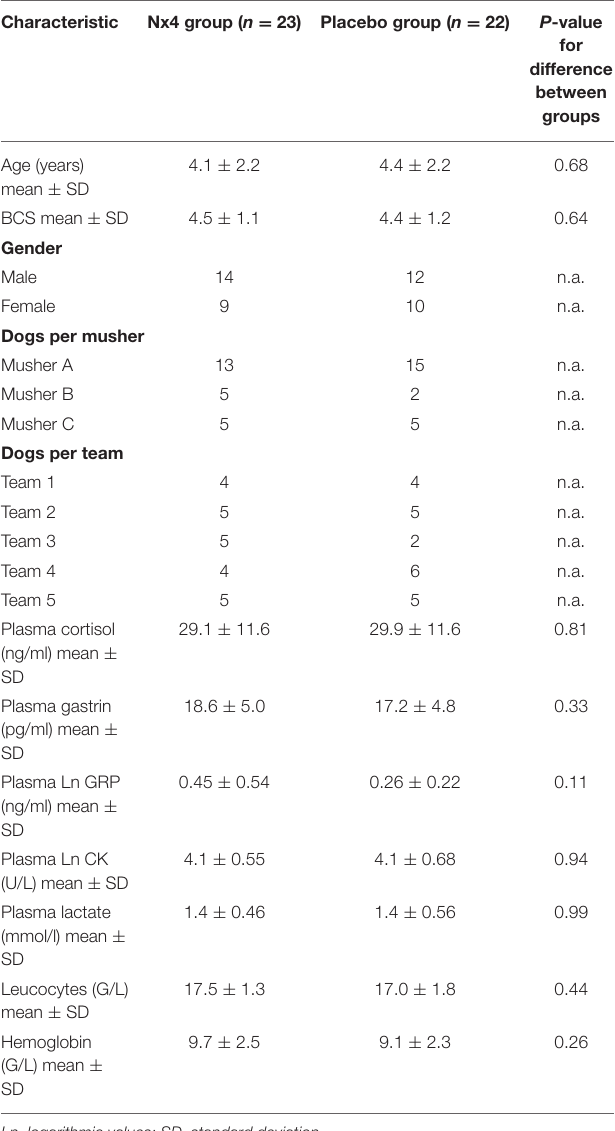
TABLE 2 | Demographic data of the main study. Characteristic Nx4 group ( n = 23) Placebo group ( n = 22) P -value